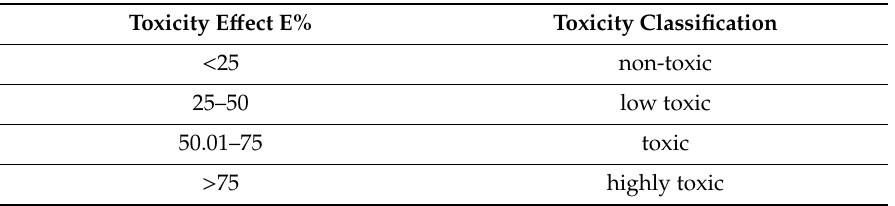
Table 5. Interpretation of the toxicity